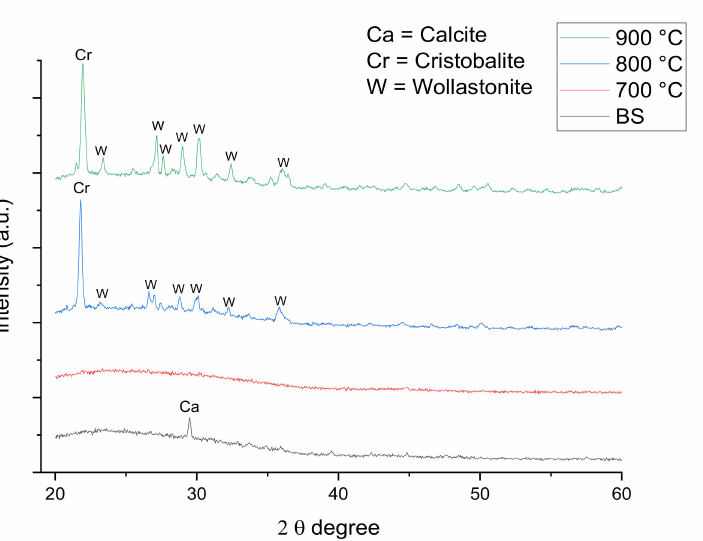
Figure 4. XRD pattern of foam glass-ceramics 1 wt% sintered at various temperatures for 60 min.